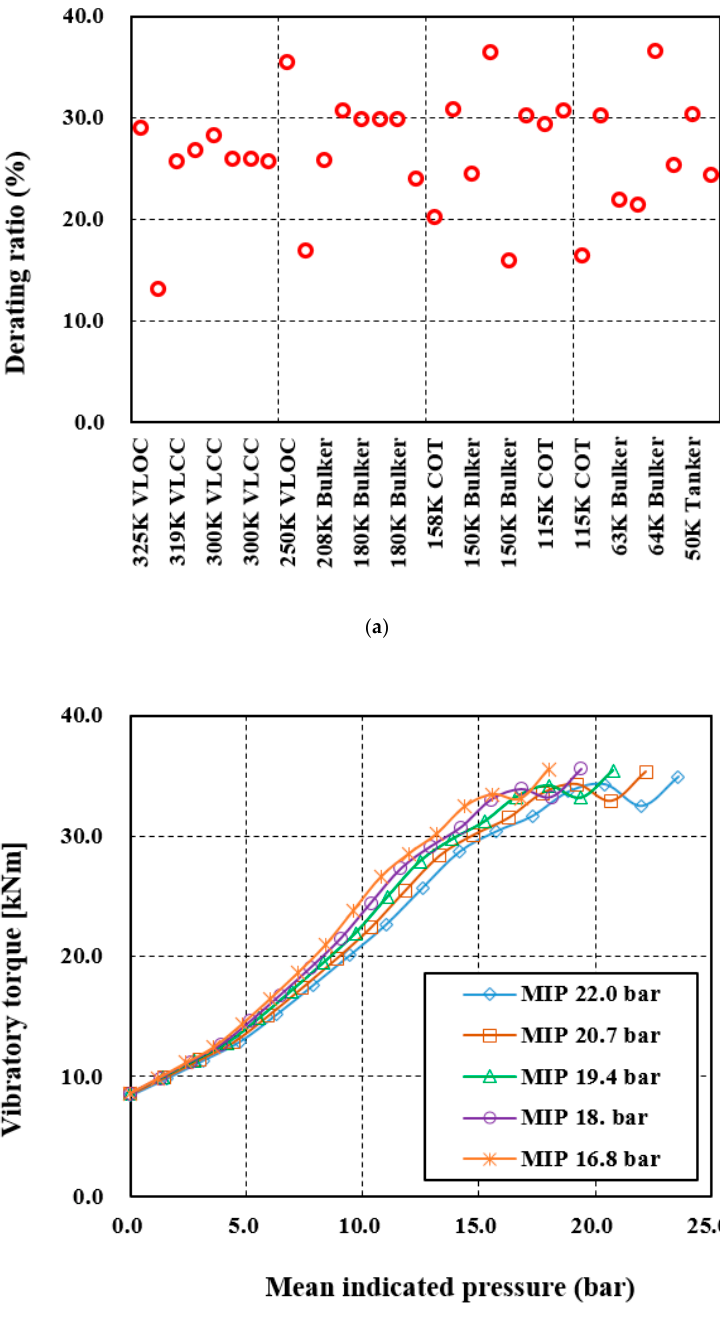
Figure 2. ( a ) De-rating ratio of ships with an ultra-long-stroke engine. ( b ) Comparison of sixth-order vibratory torque of an ultra-long-stroke engine with de-rating technology according to varied mean e ff ective indicated